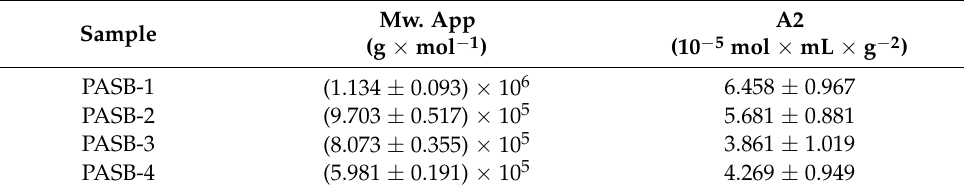
Table 3. Static laser-light-scattering data for